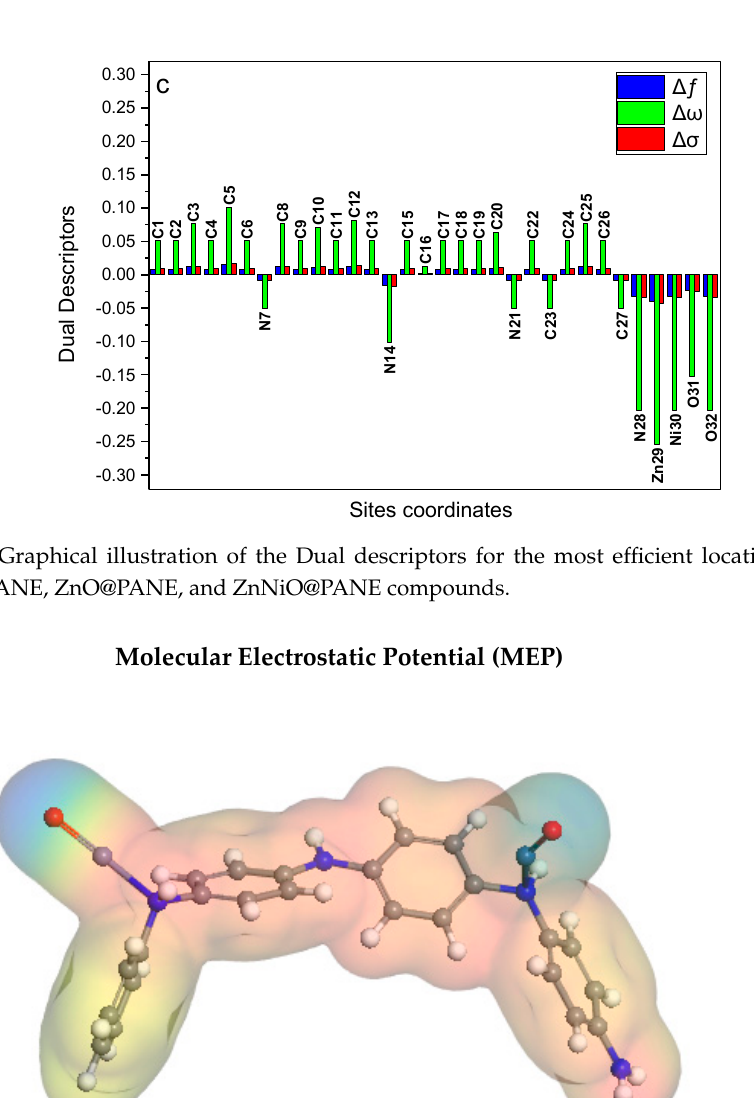
Figure 10. Graphical illustration of the Dual descriptors for the most efficient locations of the exam- ined PANE, ZnO@PANE, and ZnNiO@PANE compounds.